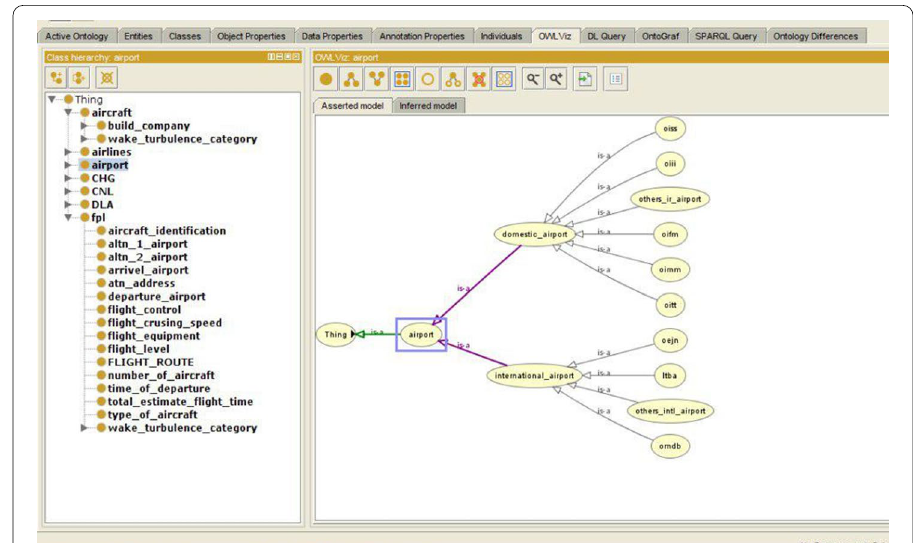
Fig. 3 Implementation of classes and subclasses in Protégé software